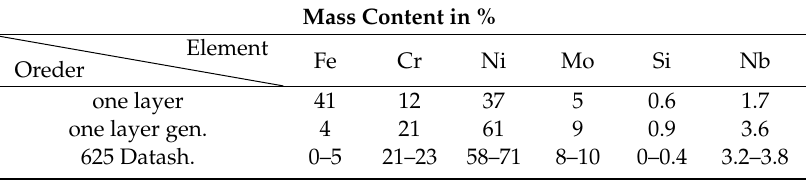
Table 6. Chemical composition of the anticorrosive layer of di ff erent